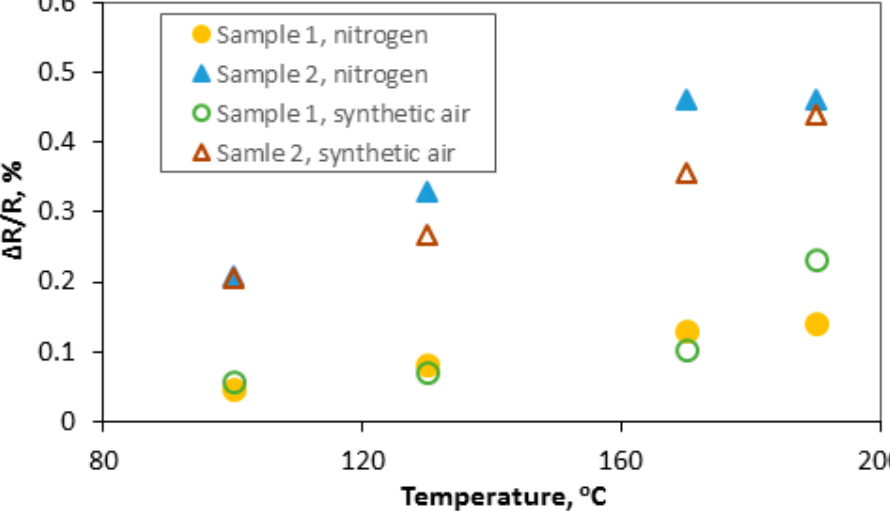
Figure A5. Di ff ractograms of graphite oxide and thermally reduced graphene oxide. Figure A5. Diffractograms of graphite oxide and thermally reduced graphene oxide.